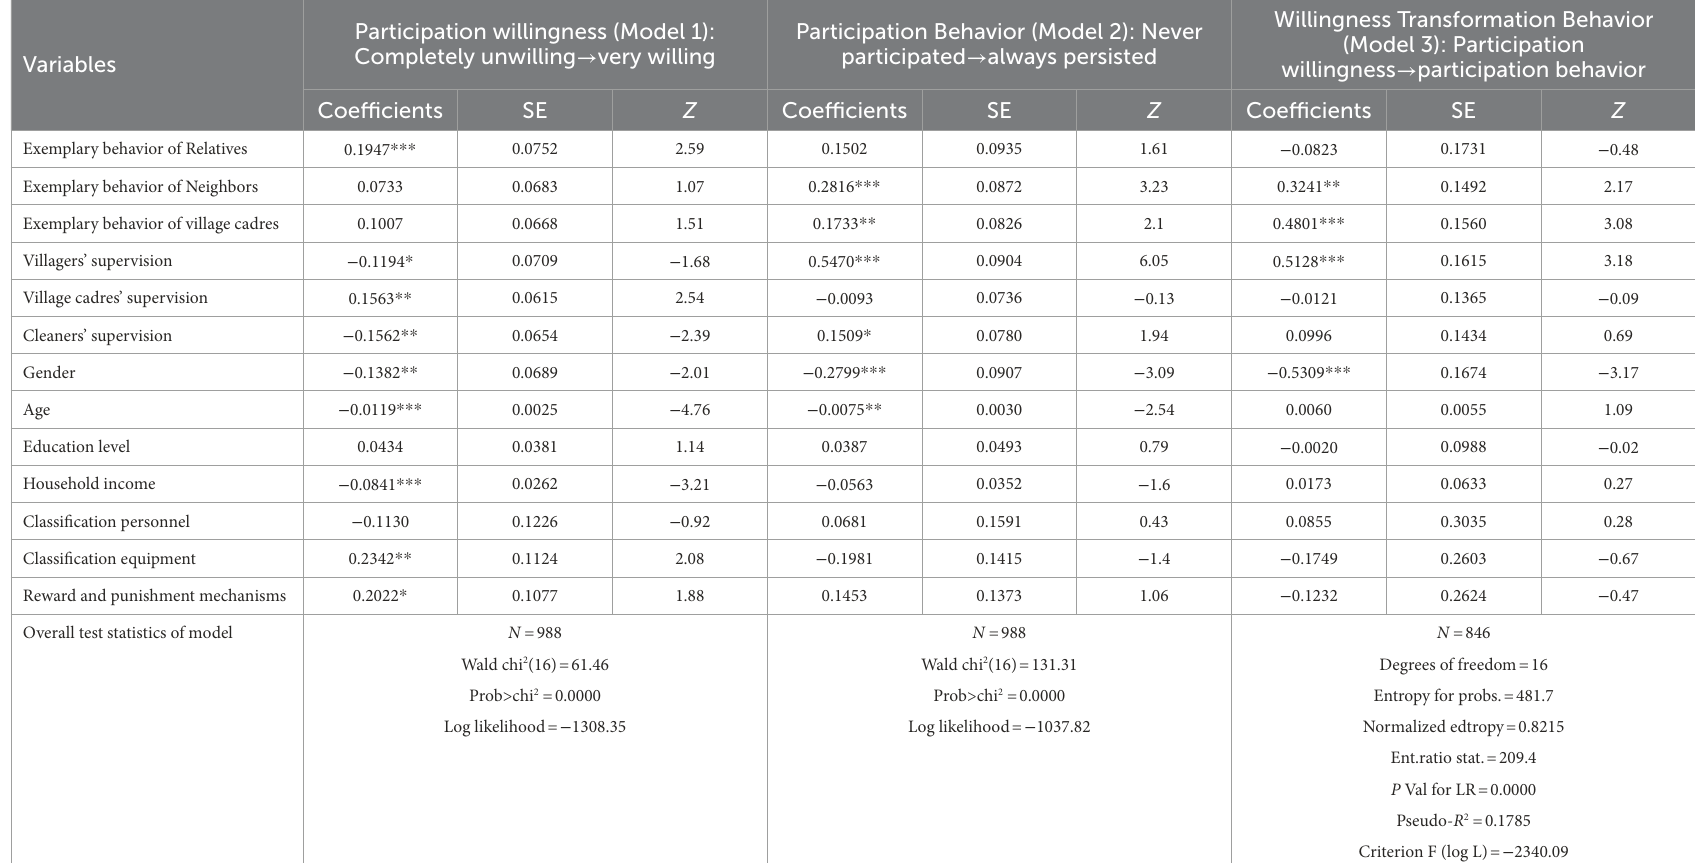
TABLE 5 Estimation results of three different models of rural residents’ willingness and behavior